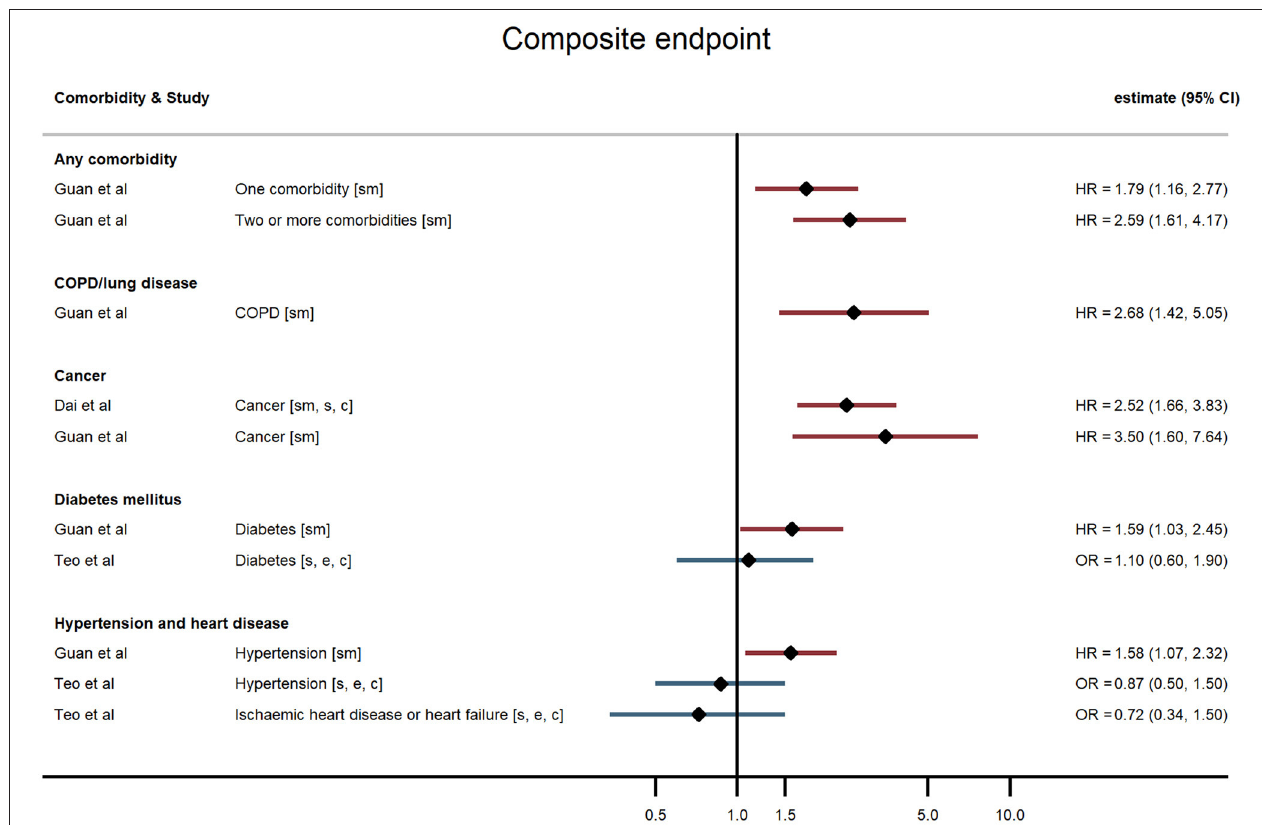
FIGURE 3 | Forest plot of study estimates of the association between comorbidities and composite severe endpoint (death, intensive care unit admission, severe or critical symptoms, or invasive mechanical ventilation) among hospitalized COVID-19 patients in the early stages of the pandemic. Reference category for each comorbidity is the absence of that comorbidity, except where stated otherwise. ICU, intensive care unit; HR, hazard ratio; OR, odds ratio; CI, confidence interval; COPD, chronic obstructive pulmonary disease. All estimates adjusted for age. Additionally adjusted for: smoking [sm]; sex [s]; other comorbidities [c]; ethnicity